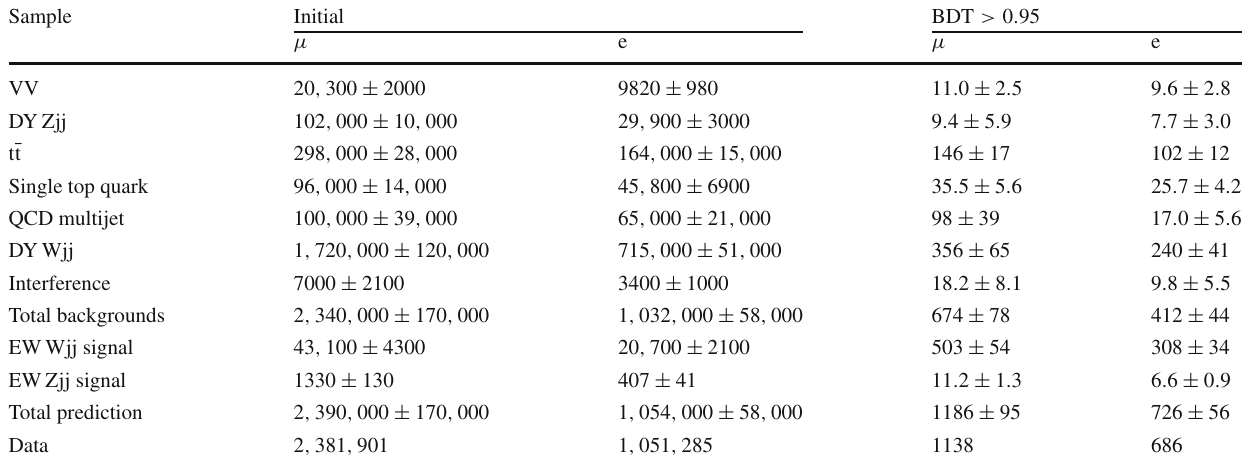
Table 1 Event yields expected for background and signal processes using the initial selections and with a selection on the multivariate anal- ysis output (BDT) that provides similar signal and background yields. The yields are compared to the data observed in the different channels